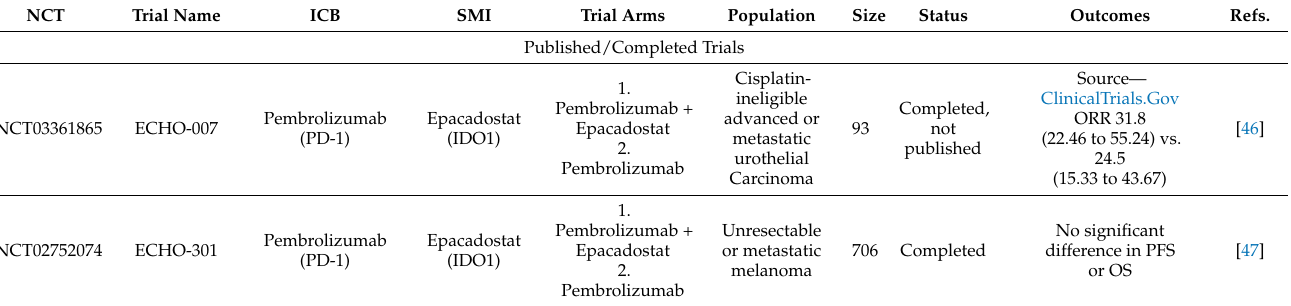
Table 2. Summary of trials combining immunotherapy and small molecule inhibitors (published or currently under trial in last 5 years). The mechanisms of action of the drug are indicated in brackets. Abbreviations: AKT—protein kinase B, ALK—anaplastic lymphoma kinase,